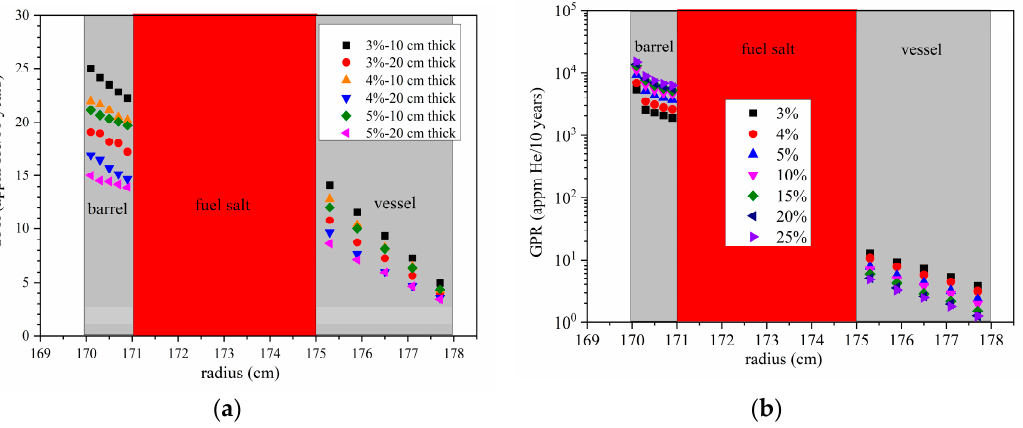
Figure 10. Helium production rates in ( a ) scheme D and ( b ) scheme E with different boron contents.